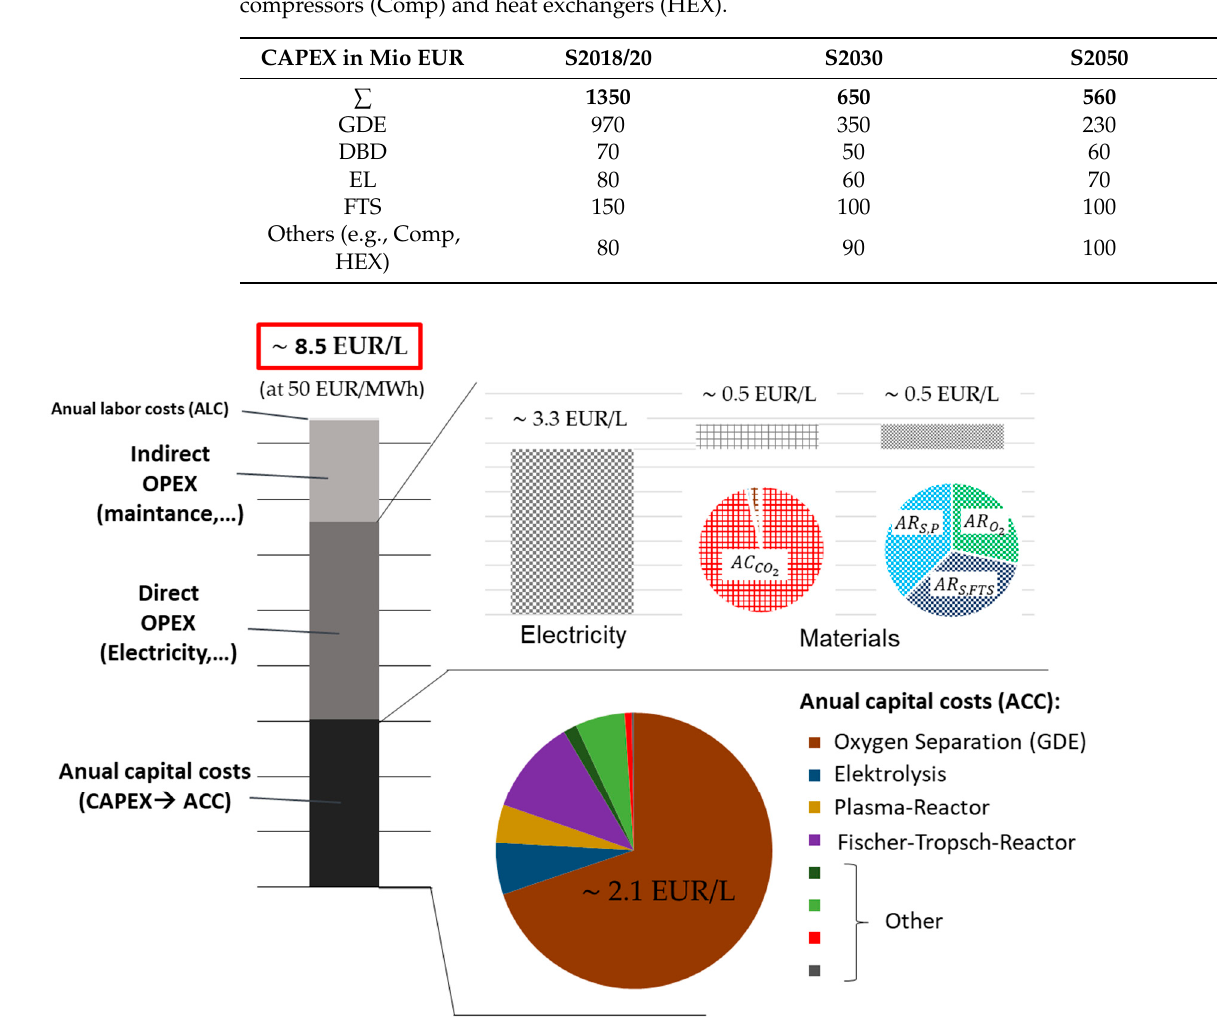
Figure 9. Distribution of net production costs (NPC) of scenario 2018/20 by dielectric barrier dis- charge (DBD)-plant.